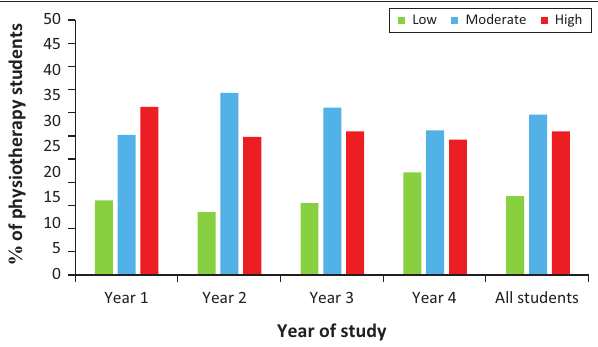
FIGURE 2: Percentage of students classified by level of physical activity based on year ( n =